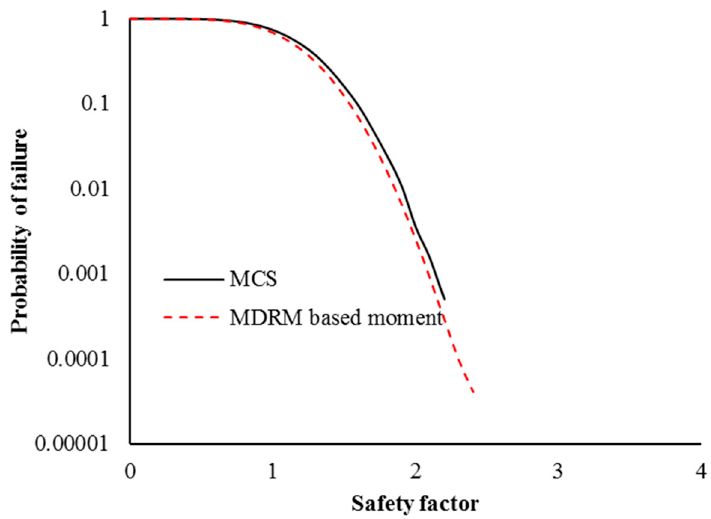
Figure 6. The relationship between probability failure and safety factor.